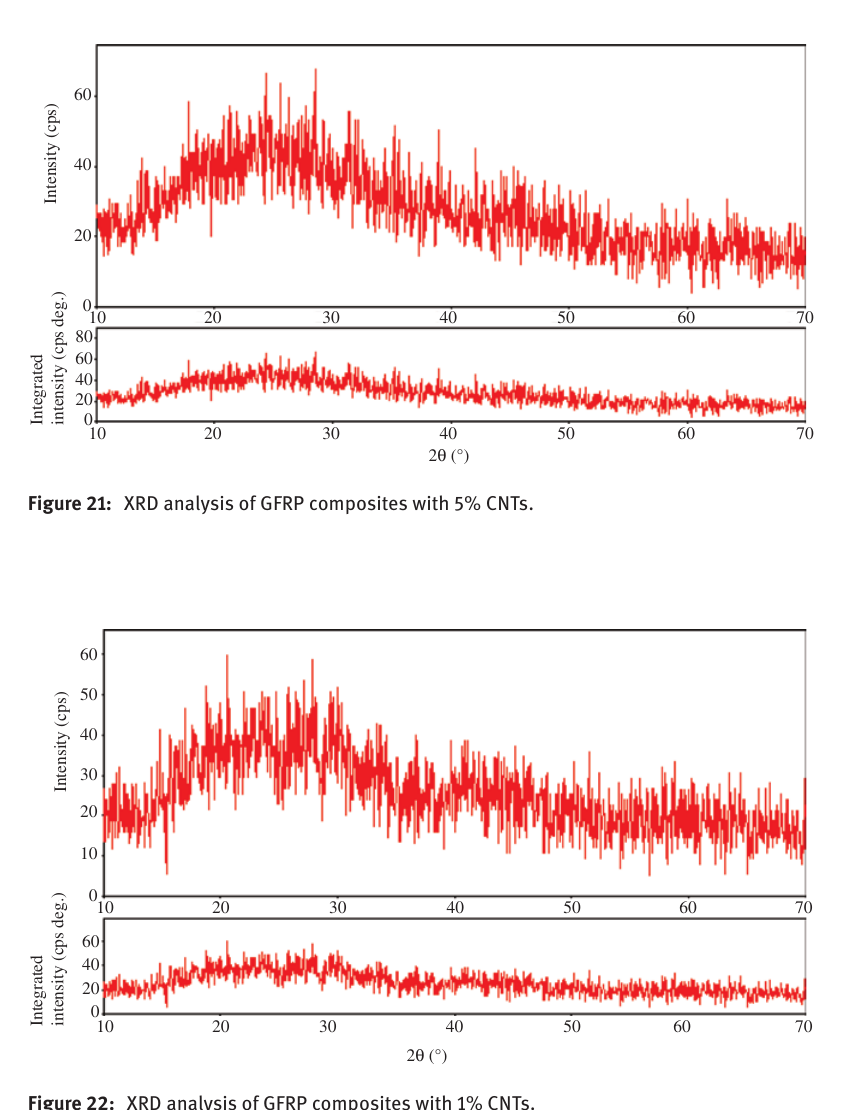
Figure 22: XRD analysis of GFRP composites with 1% CNTs.